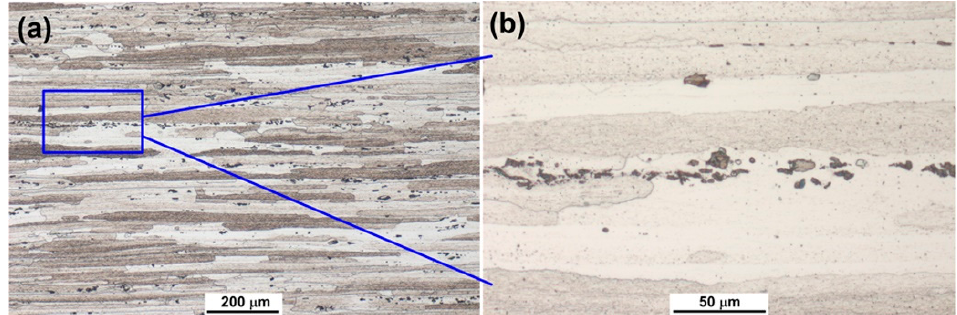
Figure 2. OM microstructures of as-received 7075 aluminum alloy. Image ( b ) shows the magnified microstructure in the frame area of image ( a ).